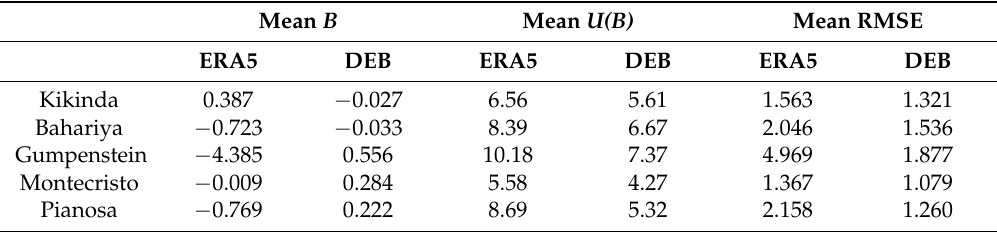
Table 2. Mean bias, mean bias uncertainty, and mean RMSE for all gap widths in selected locations.